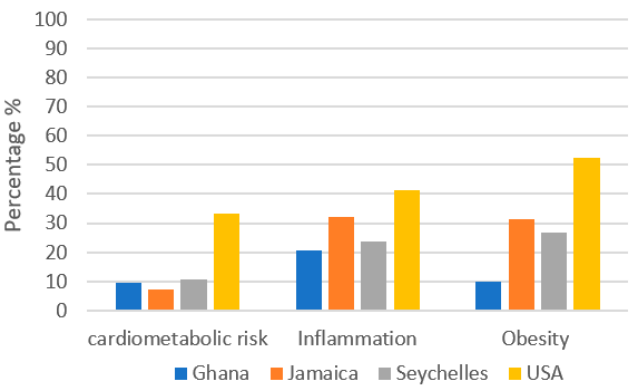
Figure 1. Comparison of prevalence for participants with at least 3/5 cardiometabolic risk factors by site.